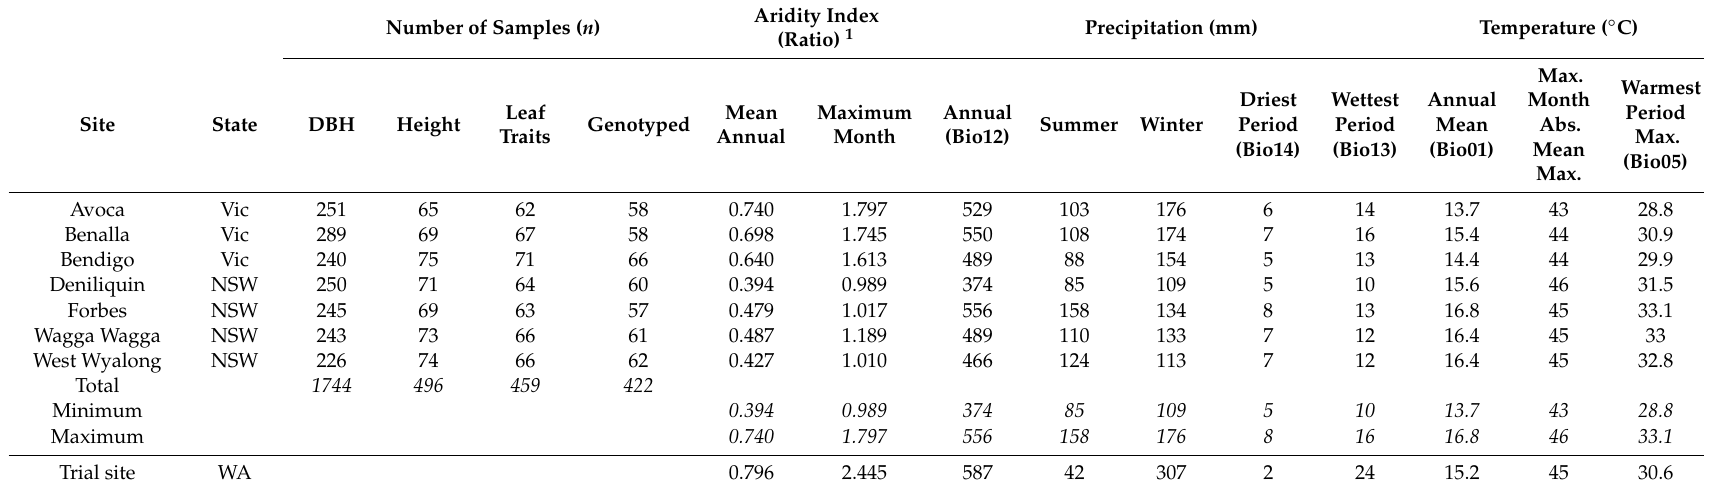
Table 1. Sample and climate data for the seven Eucalyptus microcarpa (Grey box) provenances measured in the provenance trial, including number of trees sampled for traits, number of trees genotyped, and climate data of original provenance locations. Climate data from [41]. See Table S1 for climate variable